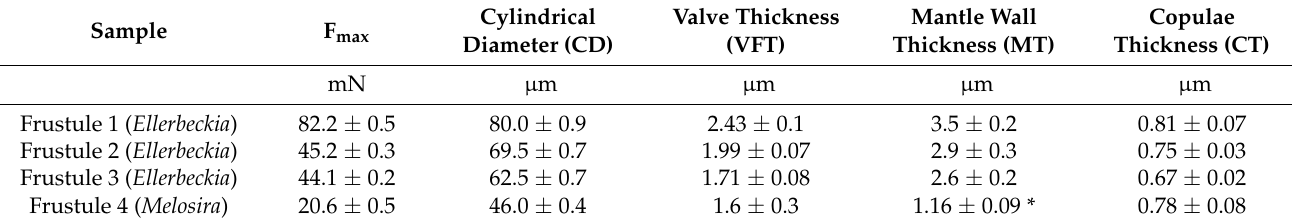
Table 1. Structure parameters and maximal loading force (F max ) of the frustules in mechanical tests.